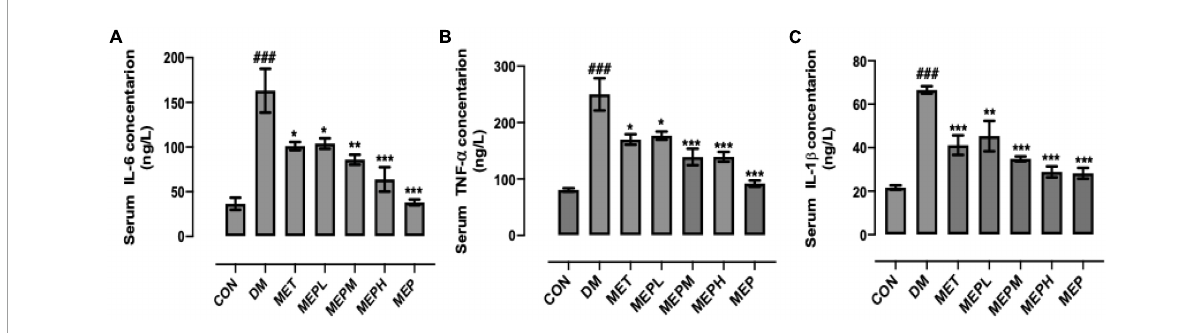
FIGURE7 Measurement of pro-inflammatory cytokines (A) IL-6, (B) TNF- α and (C) IL-1 β by ELISA in T2DM mice. The data are shown with means ± SEM. # indicates a significant difference compared with the control (CON) group. ### p < 0.001 vs. control. * indicates a significant difference compared with the DM group. * p < 0.05, ** p < 0.01, and *** p < 0.001 vs. DM.